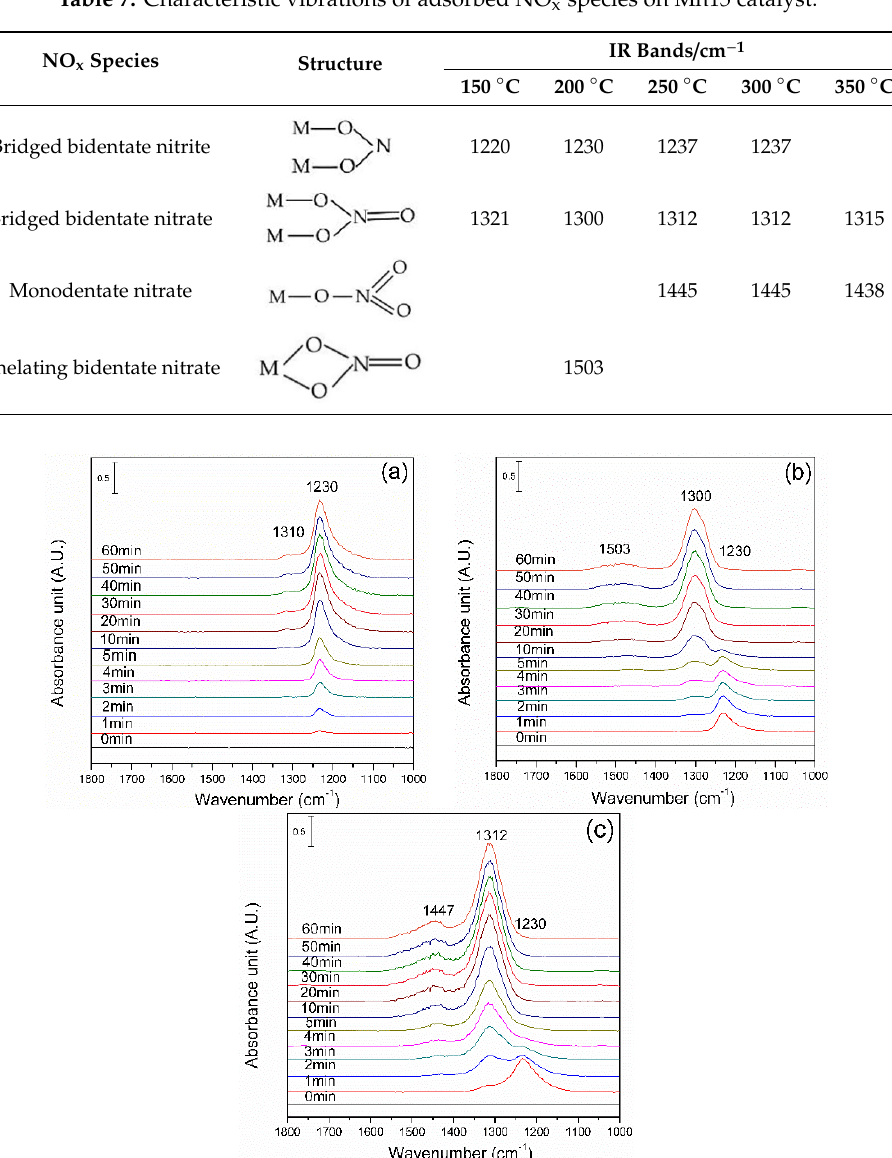
Table 7. Characteristic vibrations of adsorbed NO x species on Mn15 catalyst.